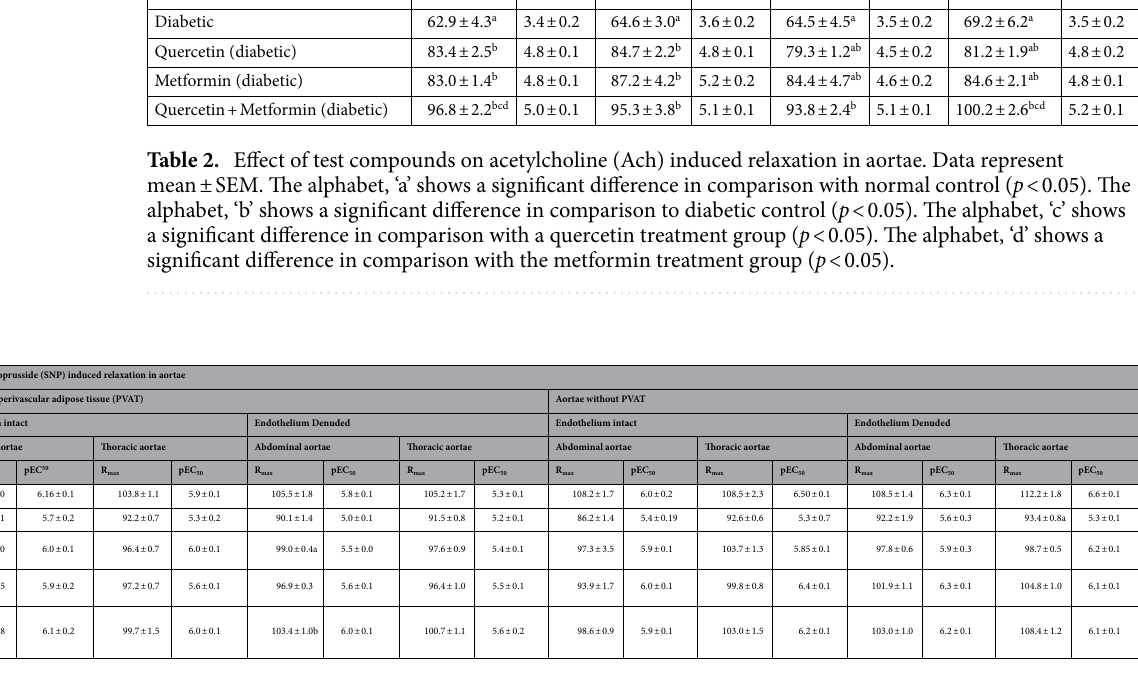
Table 3. Effect of test compounds on sodium nitroprusside (SNP) induced relaxation in aortae. Data represent mean ± SEM. The alphabet, ‘a’ shows a significant difference in comparison with normal control ( p < 0.05). The alphabet, ‘b’ shows a significant difference in comparison to diabetic control ( p <